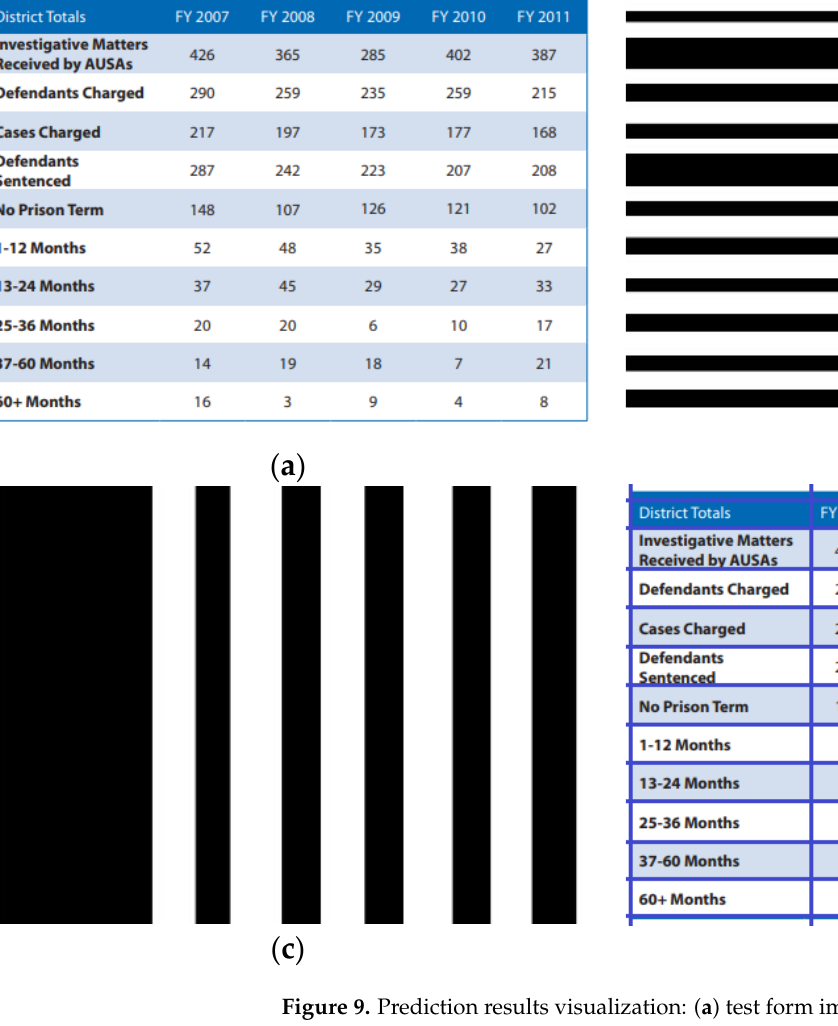
Table 6. SE module layers ablation